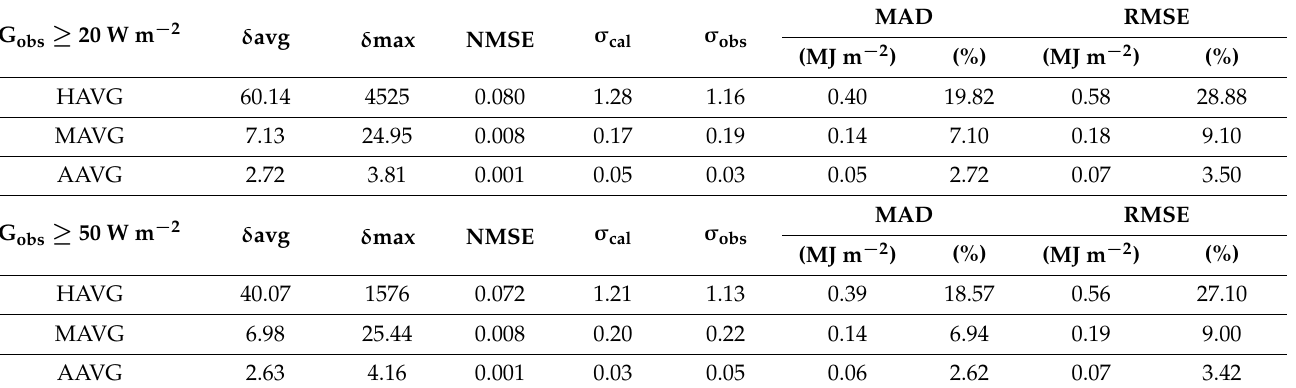
Table 2. Average and maximum of the absolute relative bias ( δ avg, δ max (%)), NMSE (MJ m − 2 ), and standard deviations of calculated and observed global solar exposure ( σ cal and σ obs , respectively, MJ m − 2 ), along with the mean bias errors (MAD, MJ m − 2 and %) and the root mean square errors (RMSE, MJ m − 2 and %). HAVG, MAVG, and AAVG are hourly, monthly, and annual averages (G obs ≥ 20 W m − 2 , n = 15,533; G obs ≥ 50 W m − 2 , n =